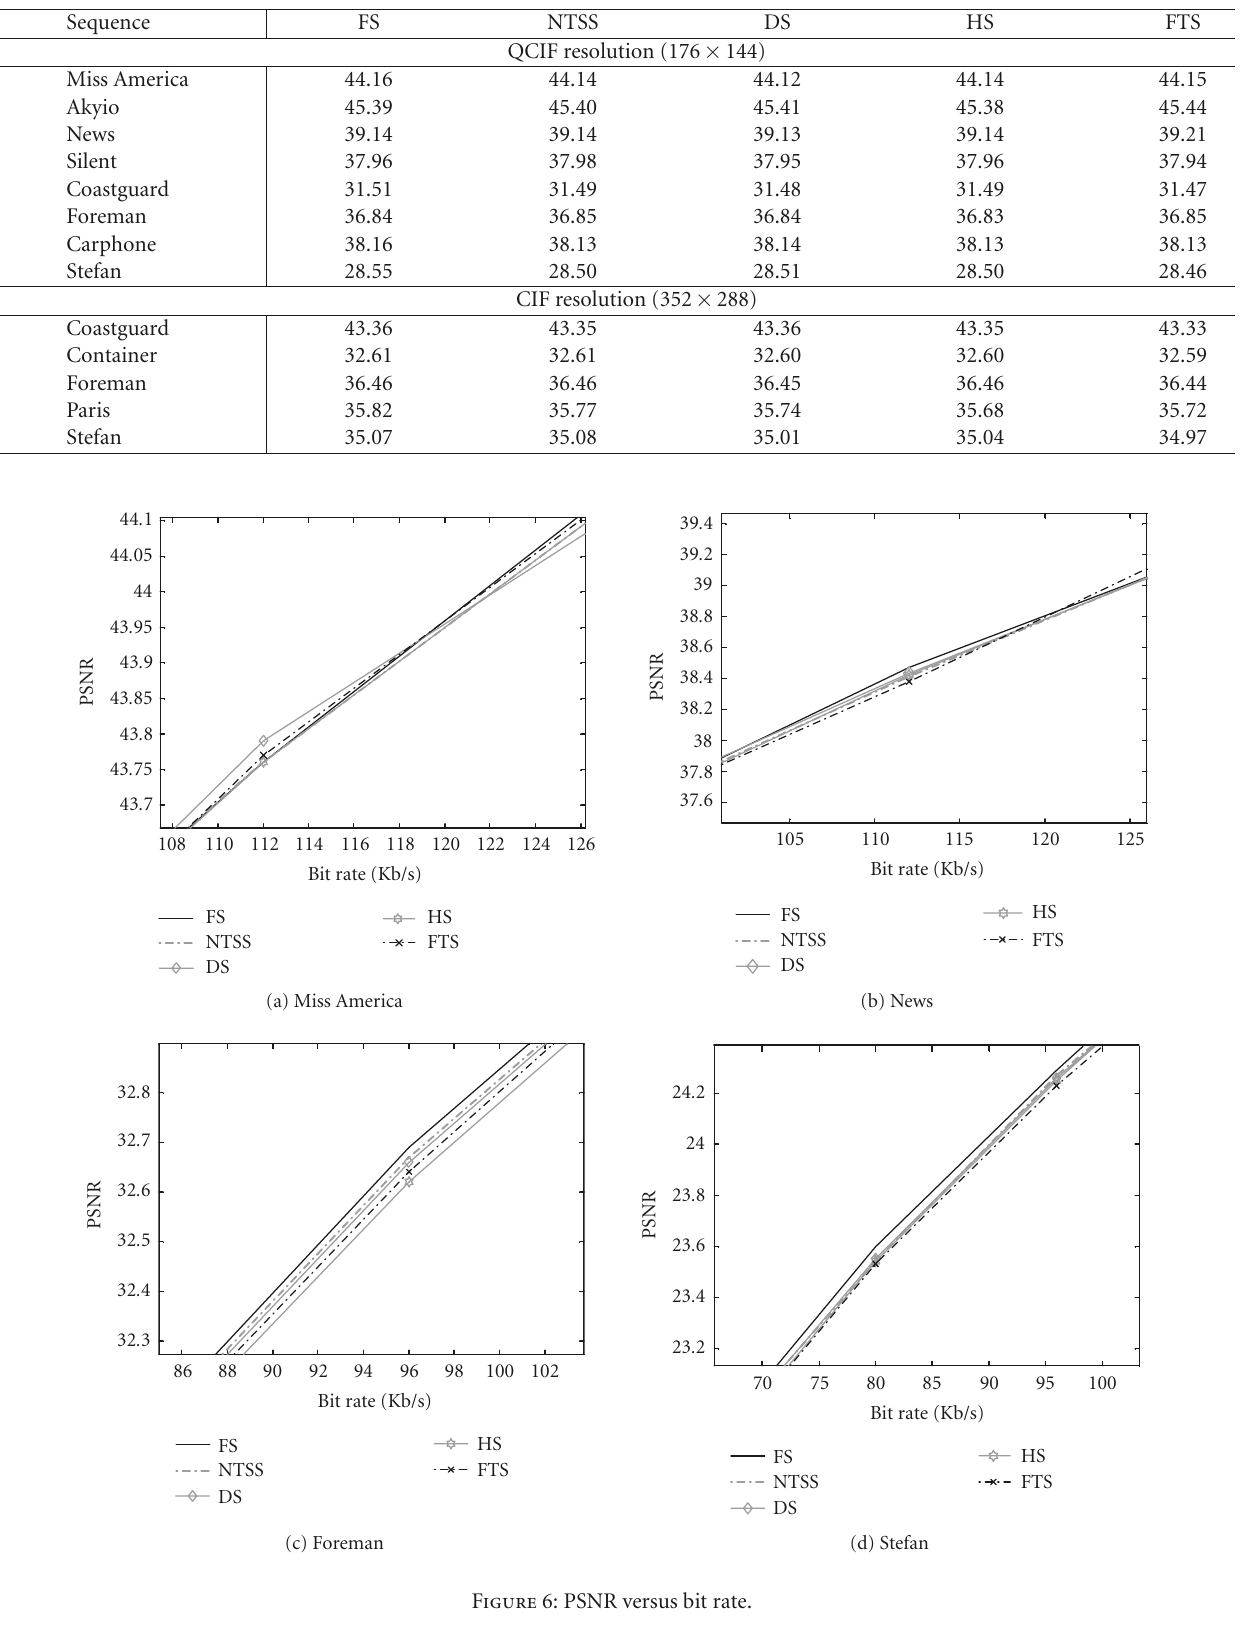
Table 6: Average PSNR (with rate control enabled).